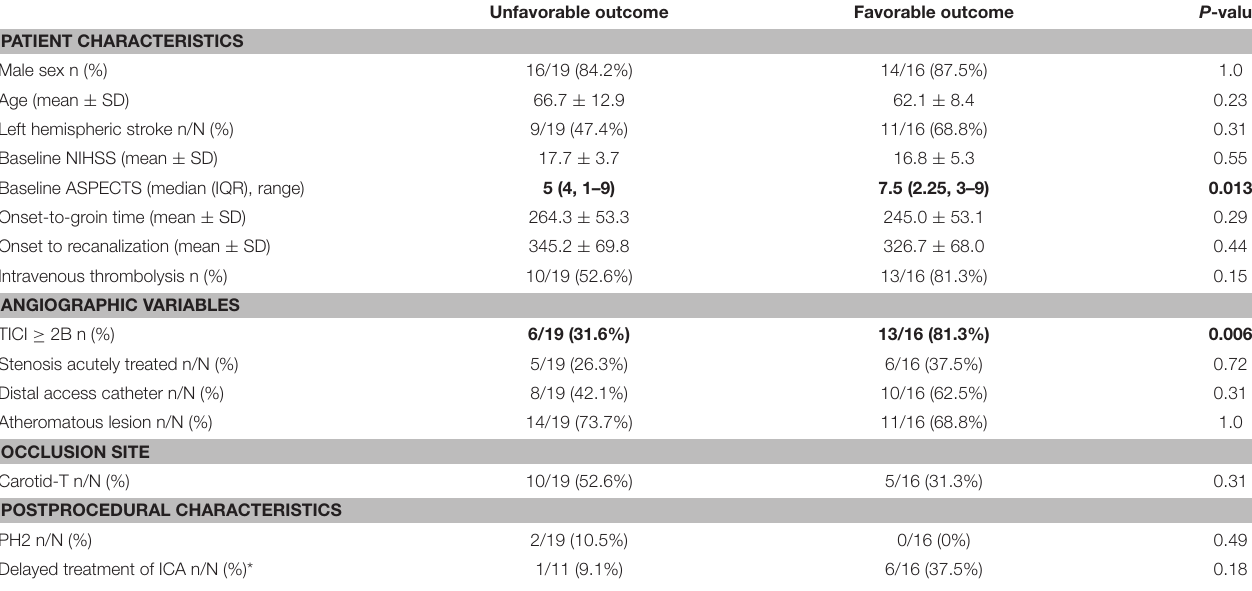
Unfavorable outcome Favorable